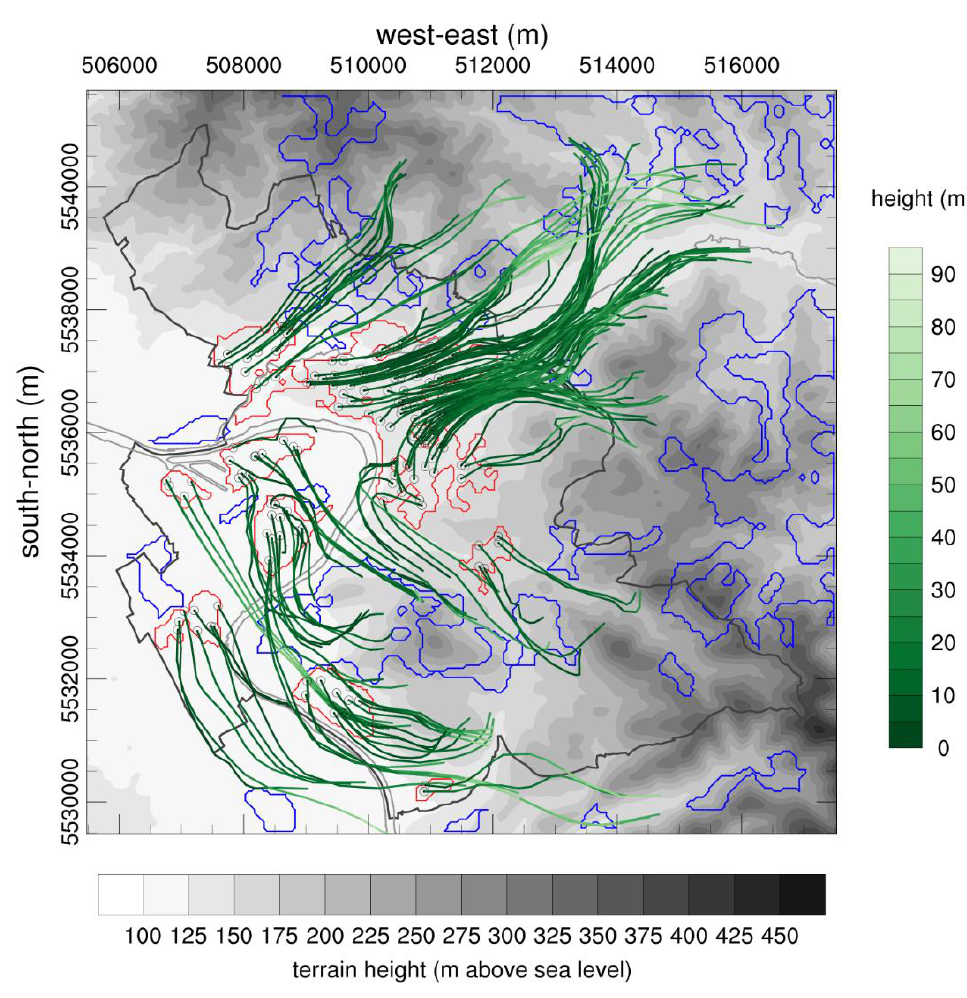
Figure 10. Backward trajectory map of the 12 km × 12 km subdomain from 03:00 to 01:00 CEST with trajectory heights above ground level in green color shading. Trajectories are released in the thermal hot spots (red) identified by z-transformation. Additionally shown are the cold air formation areas in blue, rivers in light grey, the city border of Aschaffenburg in black and terrain elevation in grey color shading.